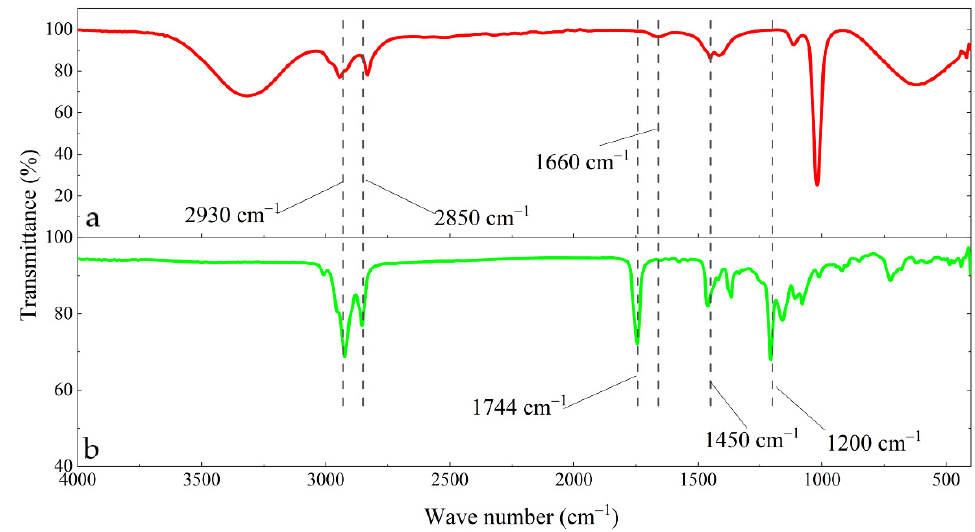
Figure 6. The spectrums of ( a ) the corrosion inhibitor solution (4 g/L) and ( b ) the surface of the carbon steel electrode in the corrosion inhibitor solution (4 g/L).